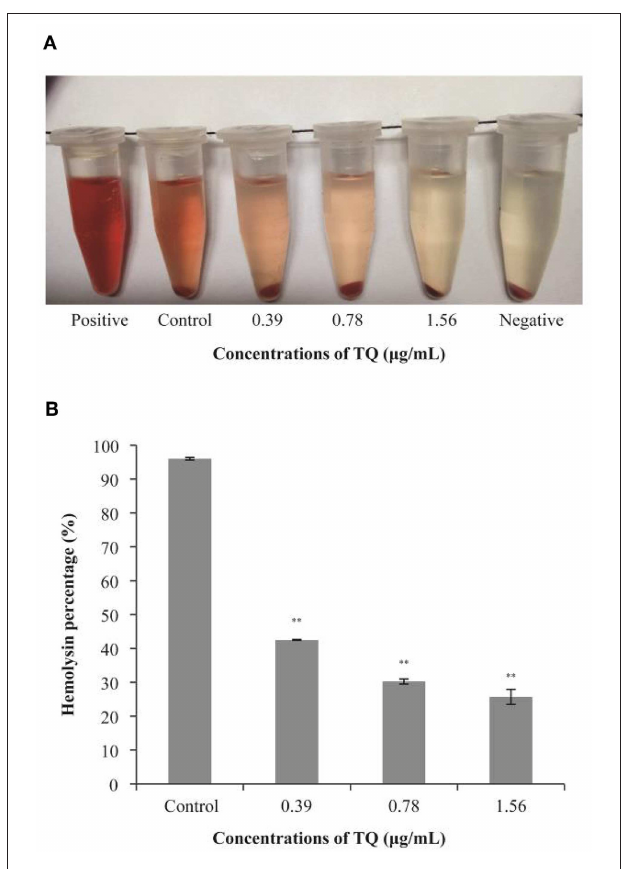
FIGURE 6 | Hemolysis of sheep red blood cells by Listeria monocytogenes ATCC 19115 culture supernatants in the absence or presence of sub-inhibitory concentrations of thymoquinone (TQ). Qualitative (A) and quantitative (B) analysis results are shown. Bars indicate the standard deviation ( n = 5). ** P < 0.01.